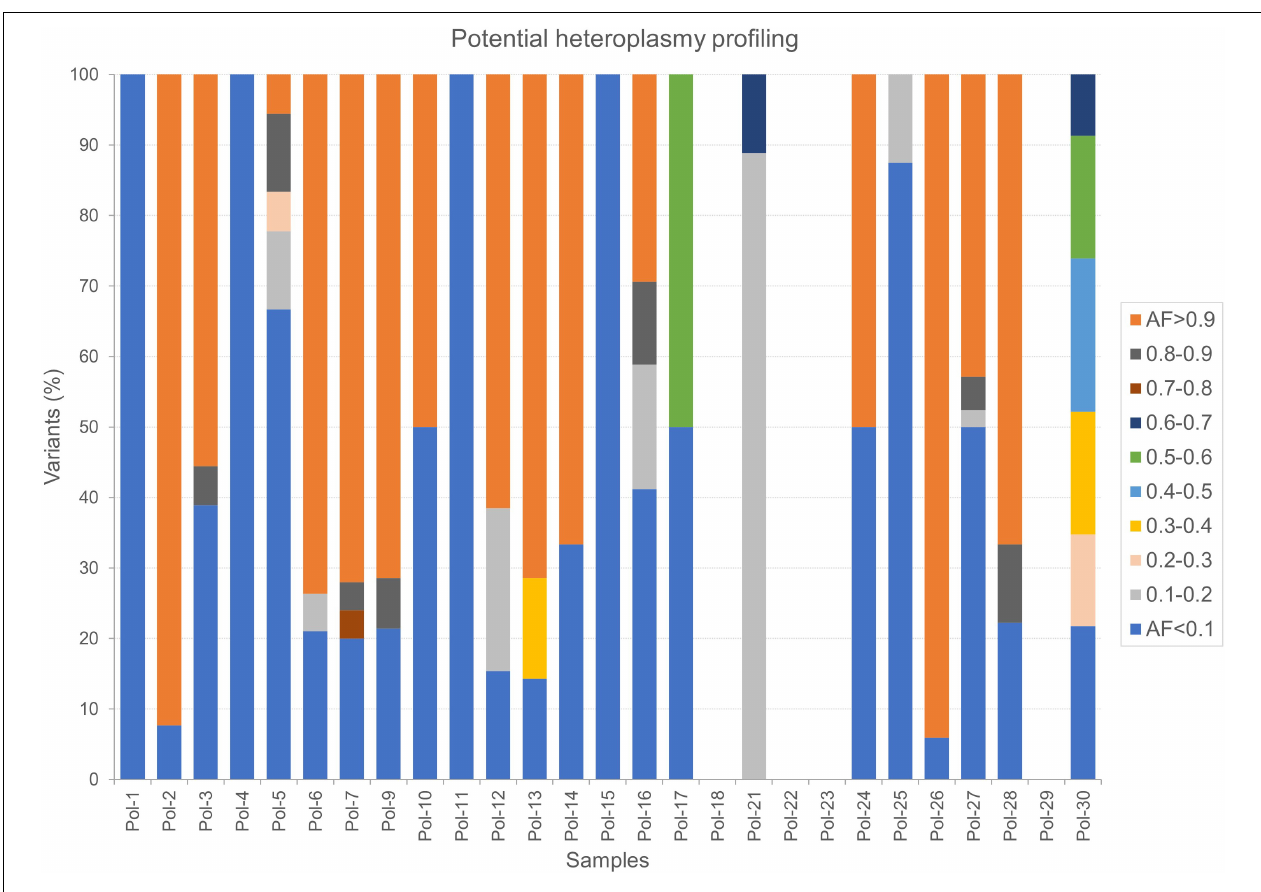
FIGURE 7 | Potential heteroplasmy profiles in Polizzello samples. The percentage of variants in each sample was calculated considering all the ranges of variant allele fraction. Here, 5% was the lowest threshold used to capture